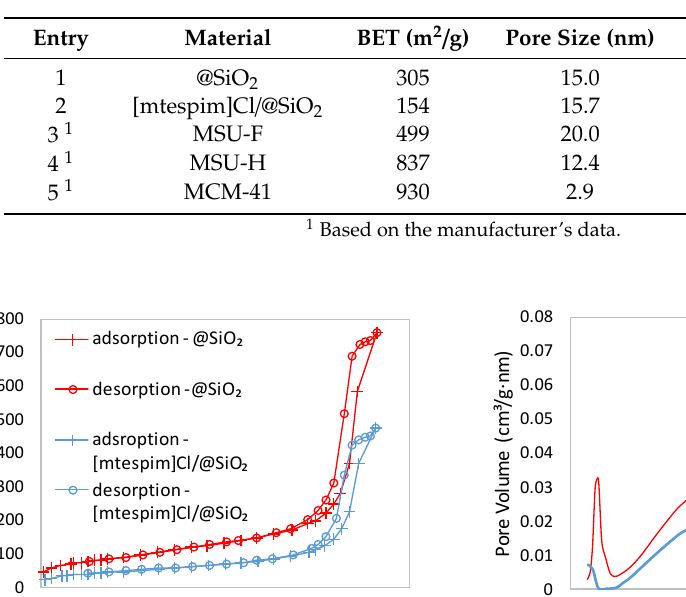
Table 1. Morphological characterization of silica carriers and IL immobilized catalyst.